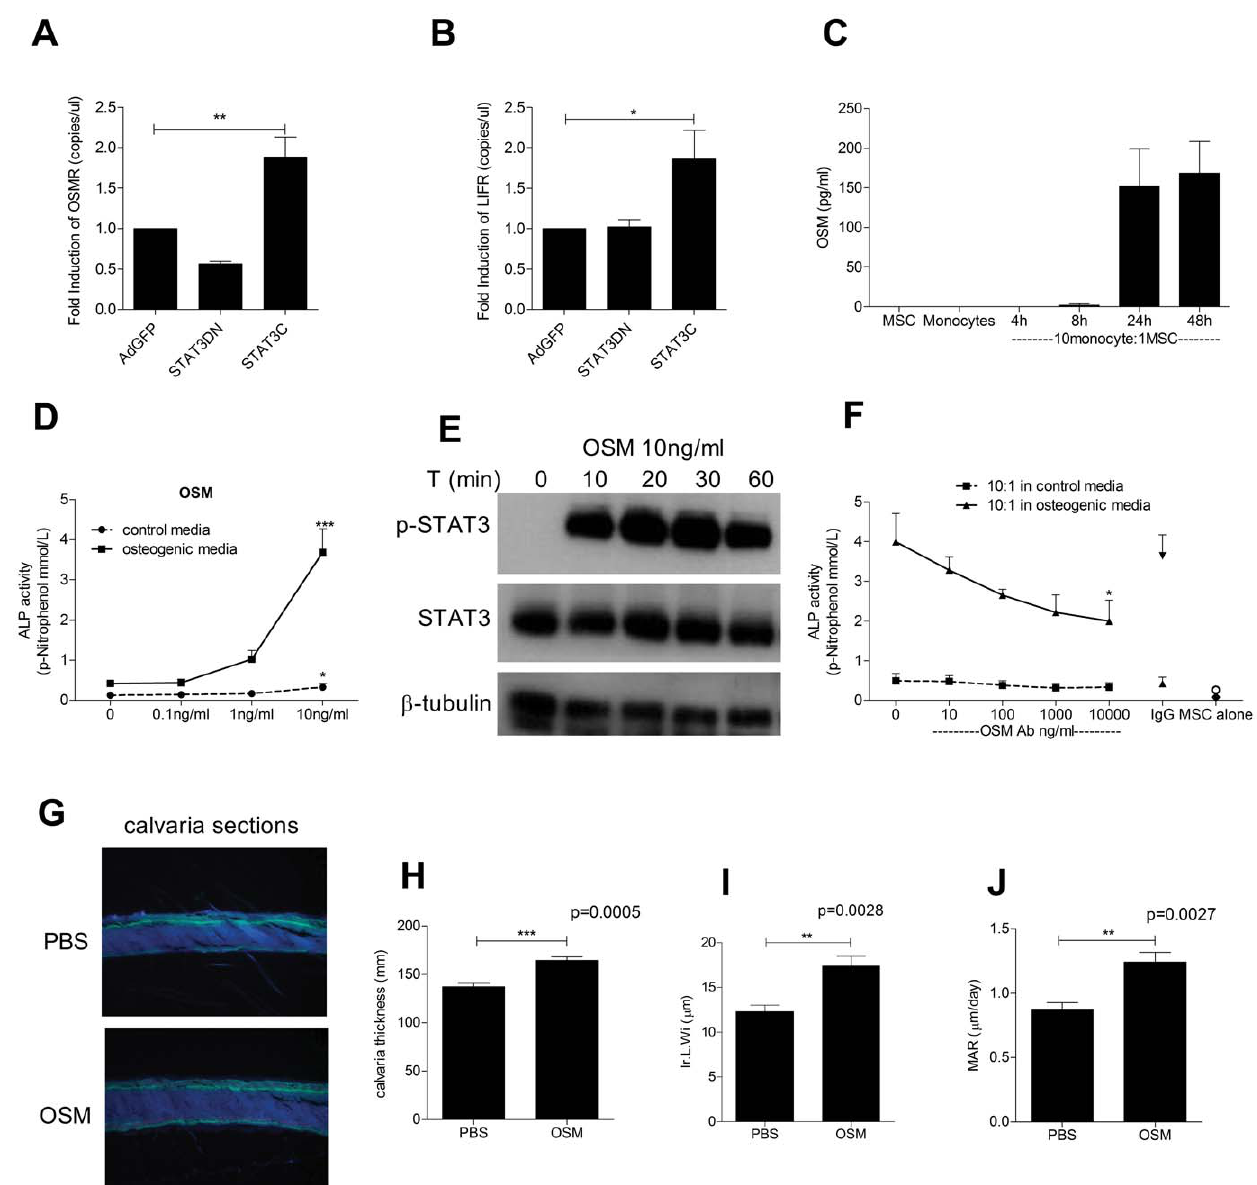
Figure 4. OSM mediates monocyte osteogenic effect. RNA was isolated from STAT3C, STAT3DN and AdGFP infected MSC after 24 h of infection and the levels of OSMR (A) and LIFR (B) mRNA were measured using real-time RT-PCR. Graphs are expressed as fold induction compared to AdGFP infected MSC. OSM levels were assessed in supernatants from either MSCs or monocytes cultured alone or MSC/monocytes co-cultured for 4 h, 8 h, 24 h and 48 h using OSM ELISA (C). MSC (1 6 10 4 ) were treated with increasing concentration of human recombinant OSM in either control or osteogenic media and ALP activity was assessed after 7 days (D). MSCs were treated with 10 ng/ml of OSM for increasing time (10, 20, 30 and 60 mins), cultures were lysed and 10 m g of protein per condition was subjected to WB for detection of pSTAT3, STAT3 and b -tubulin (E). OSM neutralising antibody was added to MSC:monocyte co-cultures at increasing concentration (10, 100, 1000 and 10000 ng/ml) in control or osteogenic media. Isotype control was also added to match the highest concentration. ALP activity was quantified after 7 days (F). Blots are representative of three independent experiments performed. Graphs show means 6 SEM of at least three independent experiments performed in triplicate. *p # 0.05 ***p # 0.001. Calcein labeled calvaria sections from mice injected daily with either recombinant murine OSM or PBS observed under fluorescent light (20X) (G). Local administration of 0.2 m g/d mOSM for 5 days in C57BL/6 mice significantly increased calvarial thickness (H), inter-label width (Ir.L.W.) (I) and mineral apposition rate (MAR) (J). Data are shown as mean + SEM, 6 mice/group. doi:10.1371/journal.pone.0039871.g004 centrifugation. Depletion and enrichment of T cells, B cells and Kit 2 for monocytes) all from Invitrogen, according to manufac- monocytes was performed using CD3, CD19 and CD14 turer’s instructions. Recombinant IL-1 b , IL-6, IL-8, TNF a , IL-10 Dynabeads and negative selection kits respectively (Dynal H T cell and OSM were purchased from Peprotech and all corresponding Negative Isolation Kit Ver II for T cells, Dynal H B Cell Negative neutralising antibodies were from R&D systems. For real-time Isolation Kit for B cells and Dynabeads H MyPure TM Monocyte reverse transcription PCR Inventoried TaqMan H Gene expression